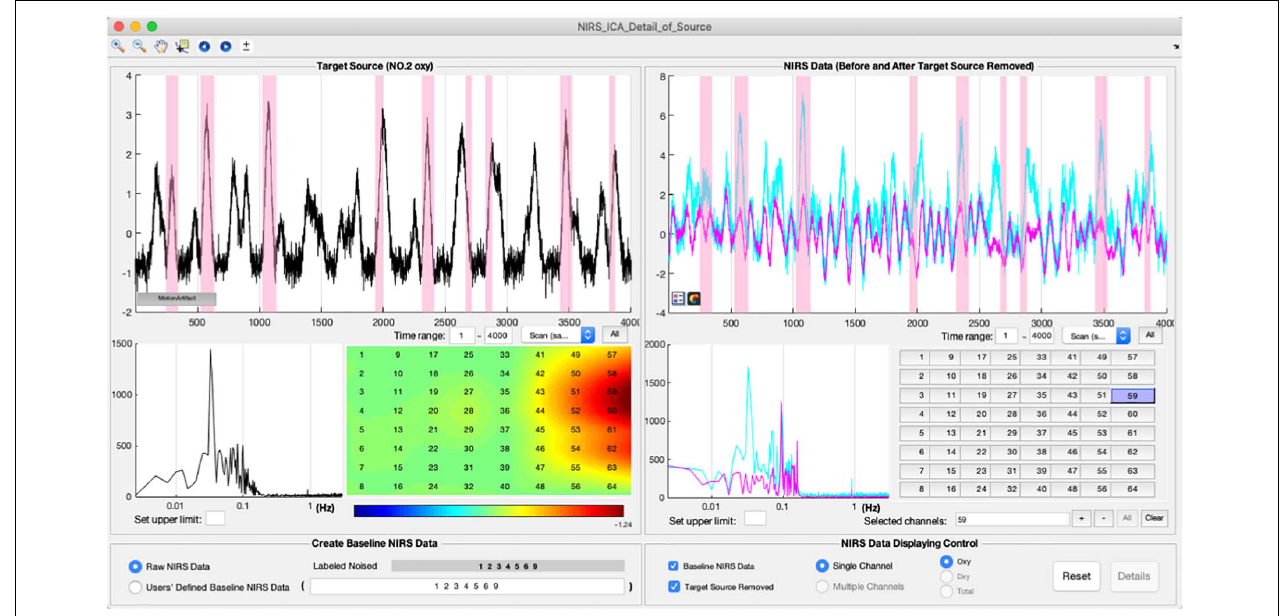
FIGURE 5 | The interface of detailed displaying sources for noise reduction. A representative source of motion artifacts is depicted using the